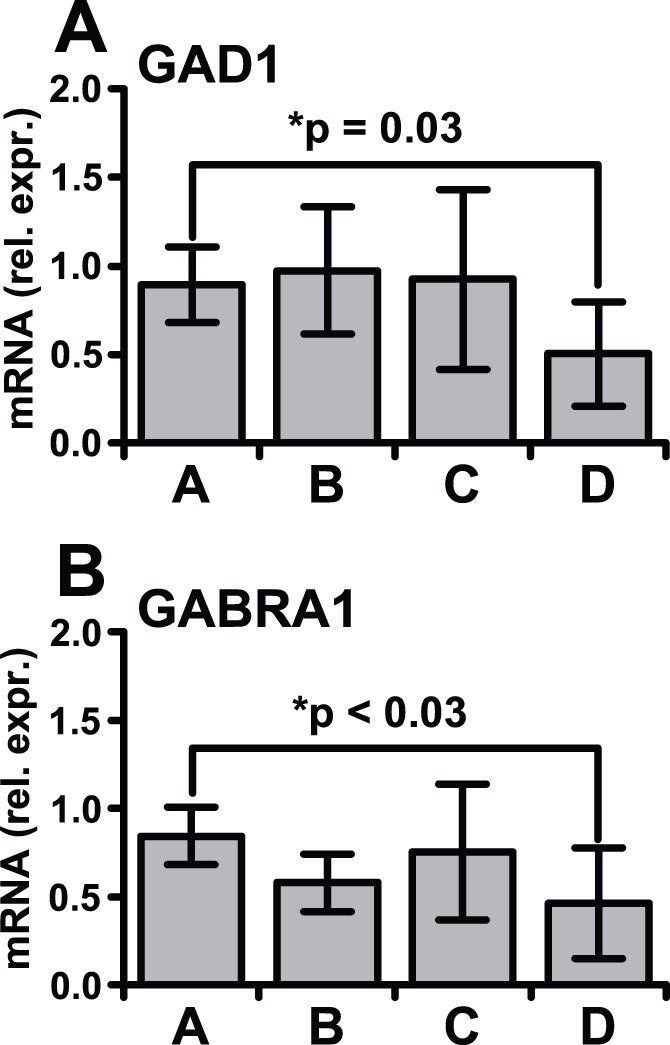
Confirmation of downregulated neocortical GABA pathway mRNAs in HIVE.
GAD1 codes for the rate limiting enzyme in GABA synthesis in presynaptic neurons (glutamic acid decarboxylase, 67 kDa). GABRA1 codes for GABA receptor subunit A1 in postsynaptic neurons. Both of these mRNAs pertain to inhibitory neocortical neurons and were significantly decreased in frontal neocortex in subjects with NCI and HIV encephalitis (Group D). NCI subjects without HIVE did not have altered GABA transcripts (Group C). mRNA is expressed relative to GAPDH mRNA. Mean ± SD, Student’s t test.